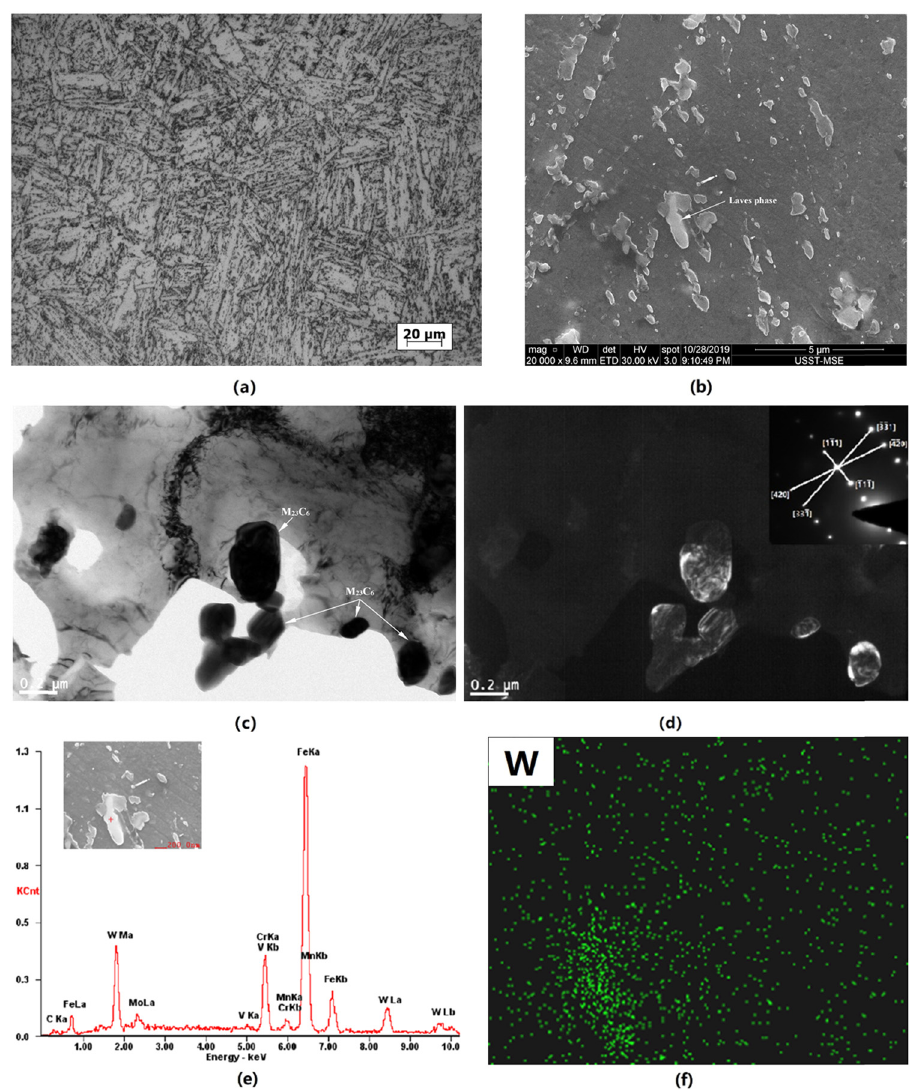
Figure 5: ( a ) OM image, ( b ) SEM image, ( c ) TEM bright - fi eld image, ( d ) TEM dark - fi eld image and SAED of M 23 C 6 , ( e ) SEM – EDS result of P92 steel after 650°C – 20,000 h aging, and ( f ) SEM – EDS mapping image of W in P92 steel after 650°C – 20,000 h